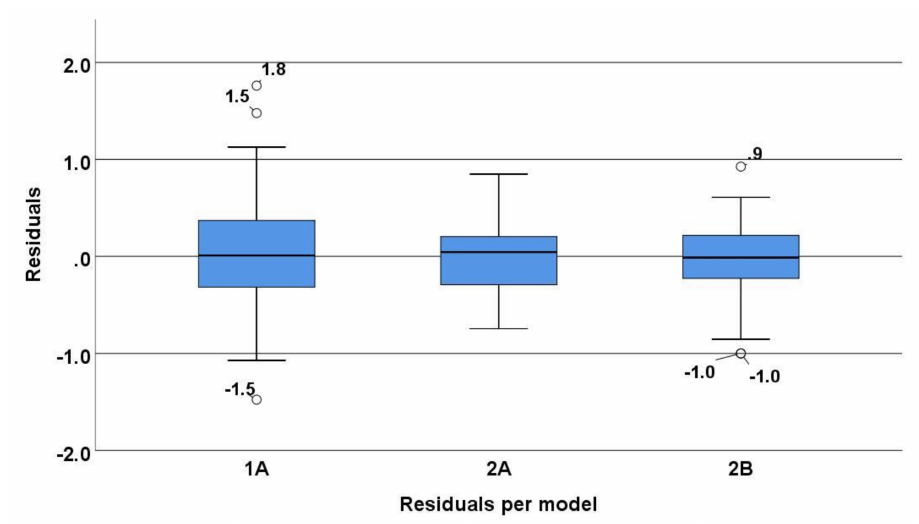
Figure 5. Boxplots presenting basic descriptive statistics of residuals per model.